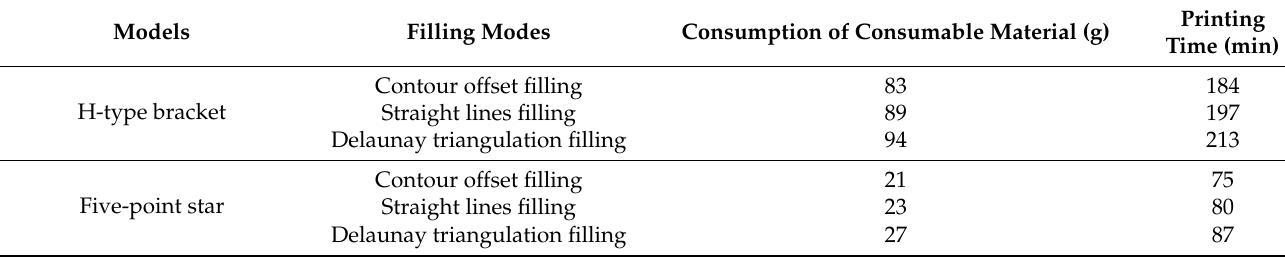
Table 4. Three kinds of filling data: comparison